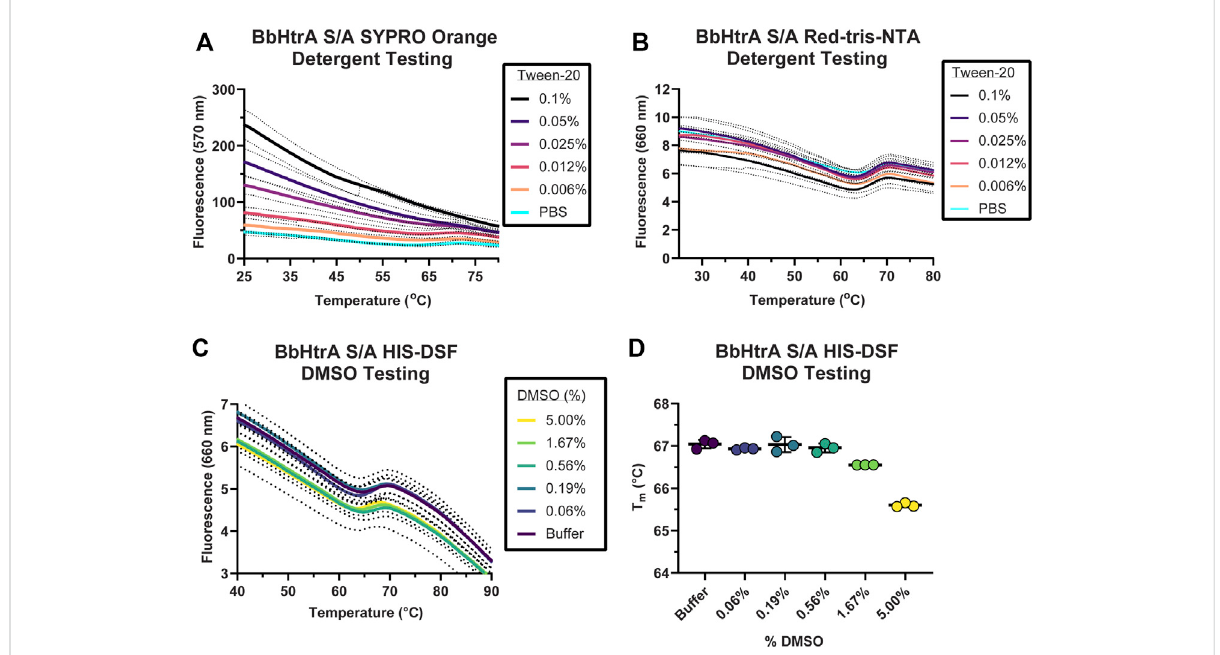
FIGURE 3 Testing buffer conditions for the HIS-DSF assay. (A,B) Melting behavior of BbHtrA S/A in presence of different concentrations of Tween-20 detergentreportedbySYPROOrange (A) orwhenlabeledwithRed-tris-NTA (B) .Linesrepresentthemeanofthreereplicateswithdotsrepresenting the standard deviation. (C) Raw thermogram of the optimized HIS-DSF BbHtrA S/A reaction in the presence of different concentrations of DMSO. Lines represent the mean of three replicates with dotted lines representing the standard deviation. (D) Scatter plot of the T m values from the optimizedHIS-DSFBbHtrAS/AreactioninthepresenceofdifferentconcentrationsofDMSO.Linesrepresentthemeanofthreereplicateswitherror bars representing the standard